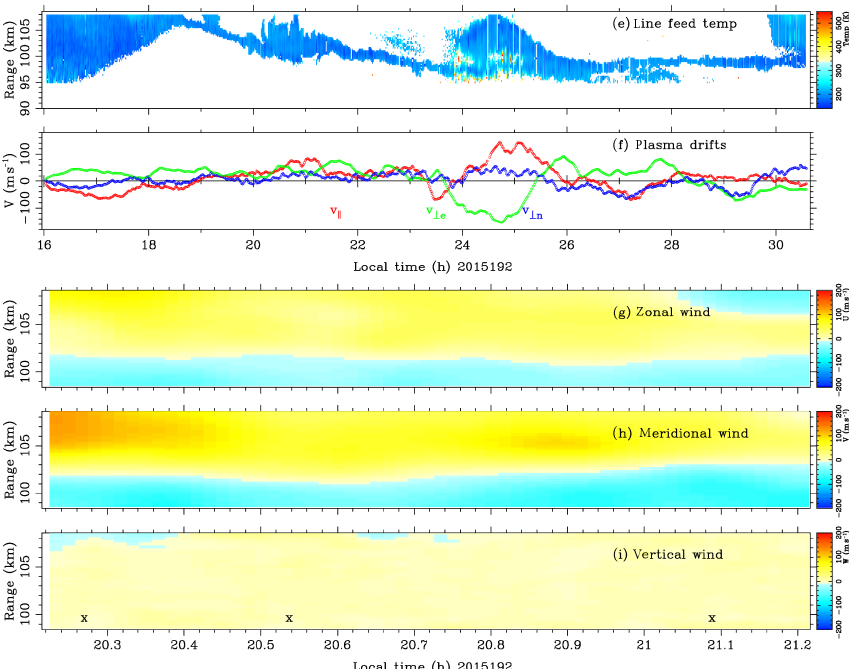
Figure 3. Detailed examination of the Arecibo dataset from 11/12 July 2015. The focus here is on the first patchy sporadic E layer. The panels are described in the text. Note that panels (a) through (d) in Fig. 2 apply to the entire experiment and are not reproduced in Figs. 3 and